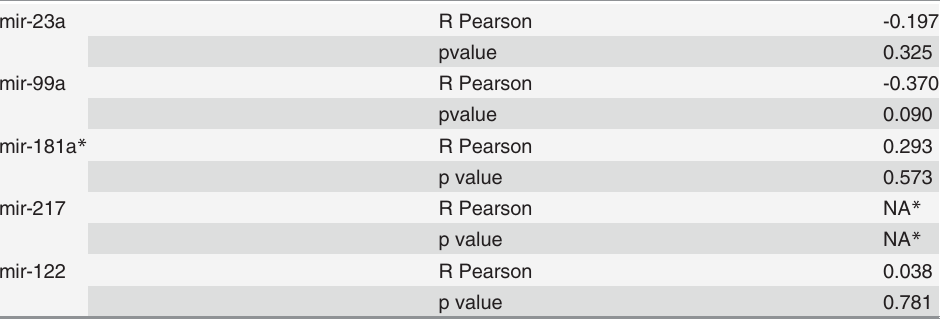
Table 3. Correlation between hepatic and serum expression of